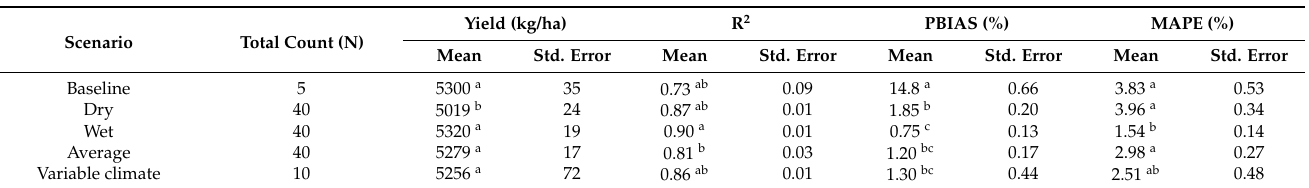
Table 4. Descriptive statistics of ANN cotton yield prediction output and performance for each dataset size and climate scenario